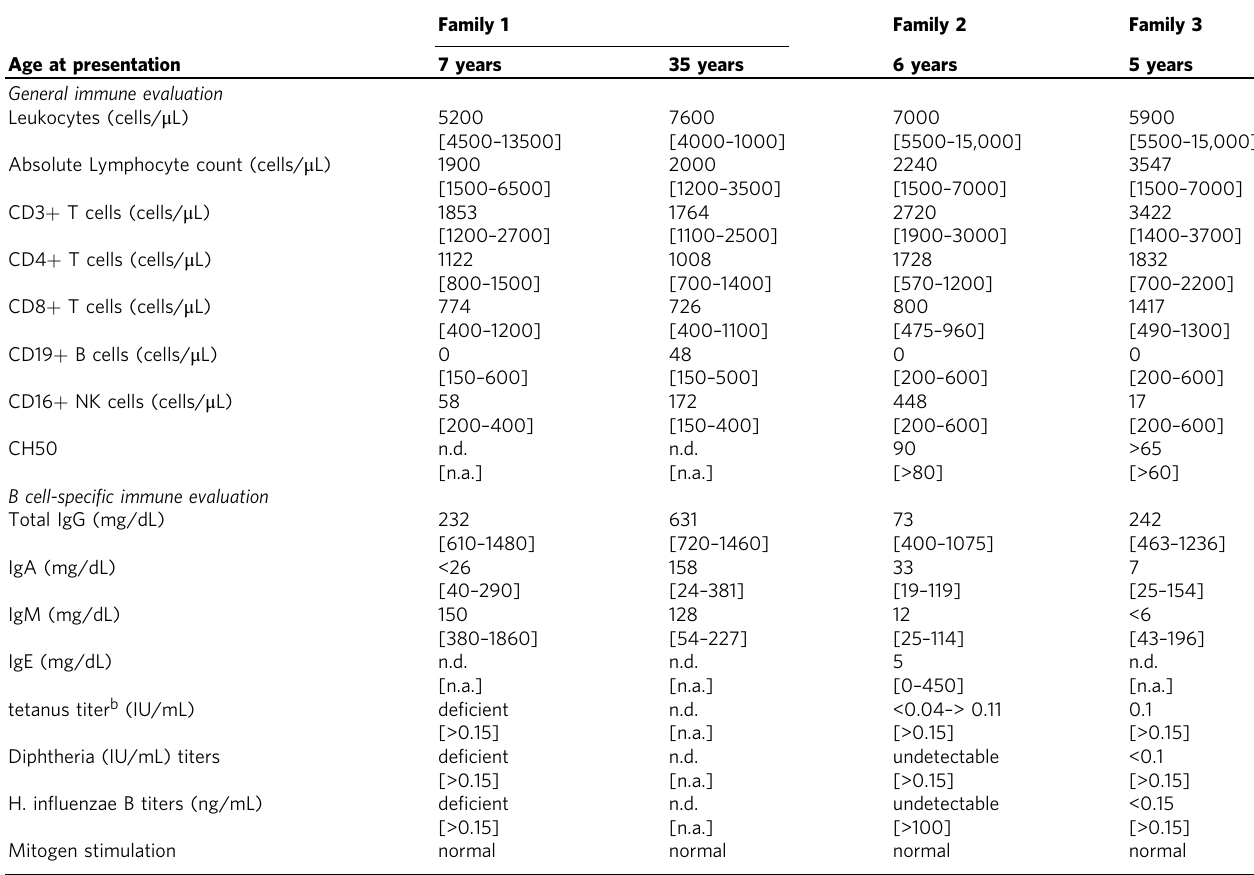
Table 1 Immunologic laboratory values at time of diagnosis of patients with TOP2B mutations